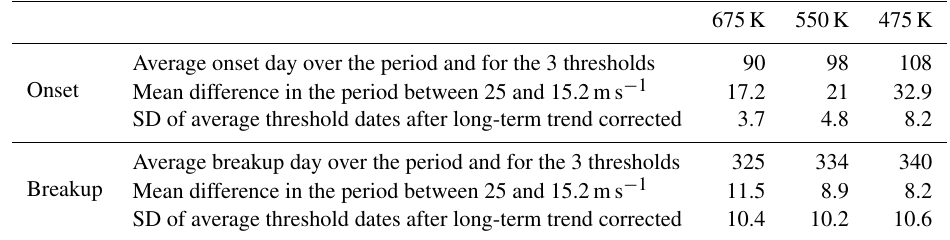
Table 3. Summary of the onset and breakup dates.